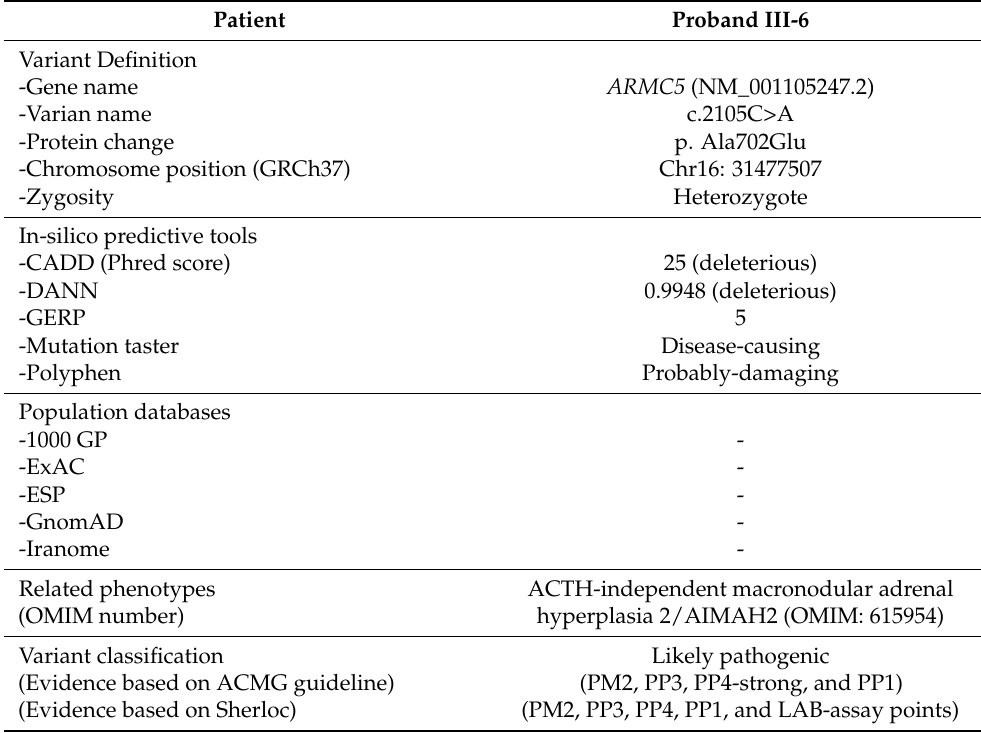
Table 2. The variant illustration of recognized variants such as in silico analysis and variant frequency in population